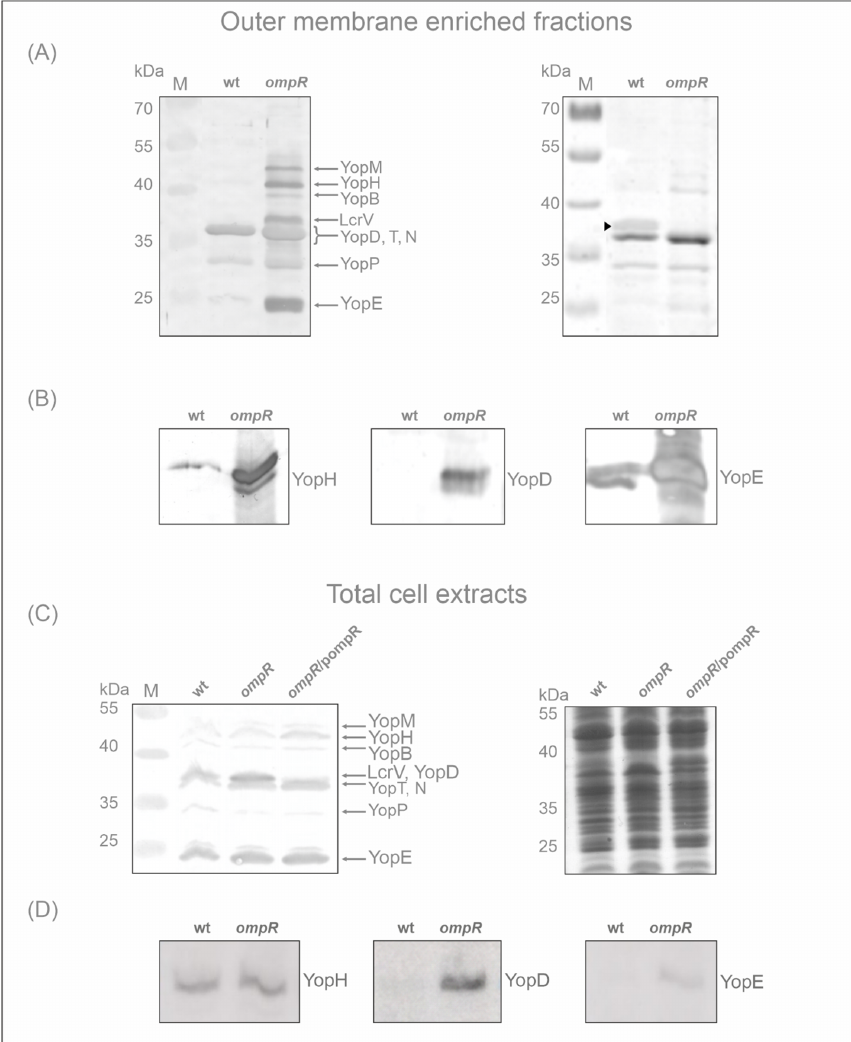
Figure 3. Effect of OmpR on the expression of Yop proteins. Yop protein abundance in Y. enterocolitica Ye9 (wt) and AR4 ( ompR ) strains were analysed by 12% SDS-PAGE and Western blotting. ( A ) Immunodetection of Yop proteins in the outer membrane-enriched sarkosyl resistant fractions utilized for MS proteomic analysis (OMsl fraction). The left panel shows a Western blot analysis of Yop proteins with an anti-Yops antiserum. The Coomassie blue-stained SDS-PAGE gel is shown in the right panel. Strains were grown in standard LB medium at 37 ◦ C. The position of the OmpC/F porin band is marked by an arrowhead on the stained gel image. The positions of the Yops (YopM, -H, -B, -D, -T, -N, -P and -E) and LcrV are indicated. M, molecular weight standards (PageRuler Prestained Protein Ladder, Thermo Fisher Scientific). ( B ) Immunodetection of YopH, YopD and YopE proteins in the OMsl fraction of the wild-type Ye9 and the ompR mutant AR4 grown in standard LB medium at 37 ◦ C, performed with specific anti-YopH, -YopD and -YopE polyclonal antibodies. ( C ) Immunodetection of Yop proteins in total cell extracts with anti-Yops antiserum. The strains (wt, ompR and ompR /pompR) were grown in standard LB medium at 37 ◦ C and equivalent whole-cell lysate samples were analysed. The left panel shows a Western blot analysis of Yop proteins. The Coomassie blue-stained SDS-PAGE gel is shown in the right panel. The positions of the Yops (YopM, -H, -B, -D, -T, -N, -P, -E) are indicated. M, molecular weight standards (PageRuler Prestained Protein Ladder, Thermo Fisher Scientific). ( D ) Immunodetection of the YopH, YopD and YopE proteins in total cell extracts of the wild-type strain and the ompR mutant grown in standard LB medium at 37 ◦ C, using specific anti-YopH, -YopD and -YopE antibodies. Equivalent whole-cell lysate samples were